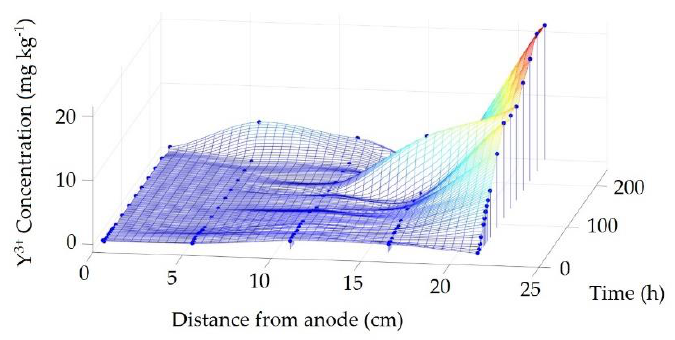
Figure 7. Y 3+ concentration profile in the real soil.